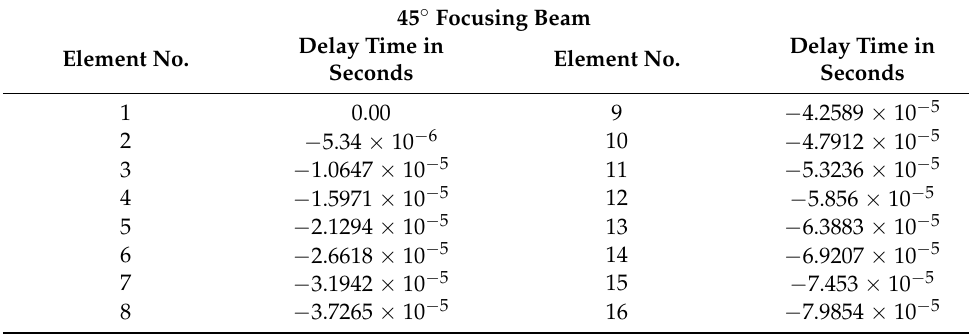
Table A2. Calculated delay time for third generation borehole